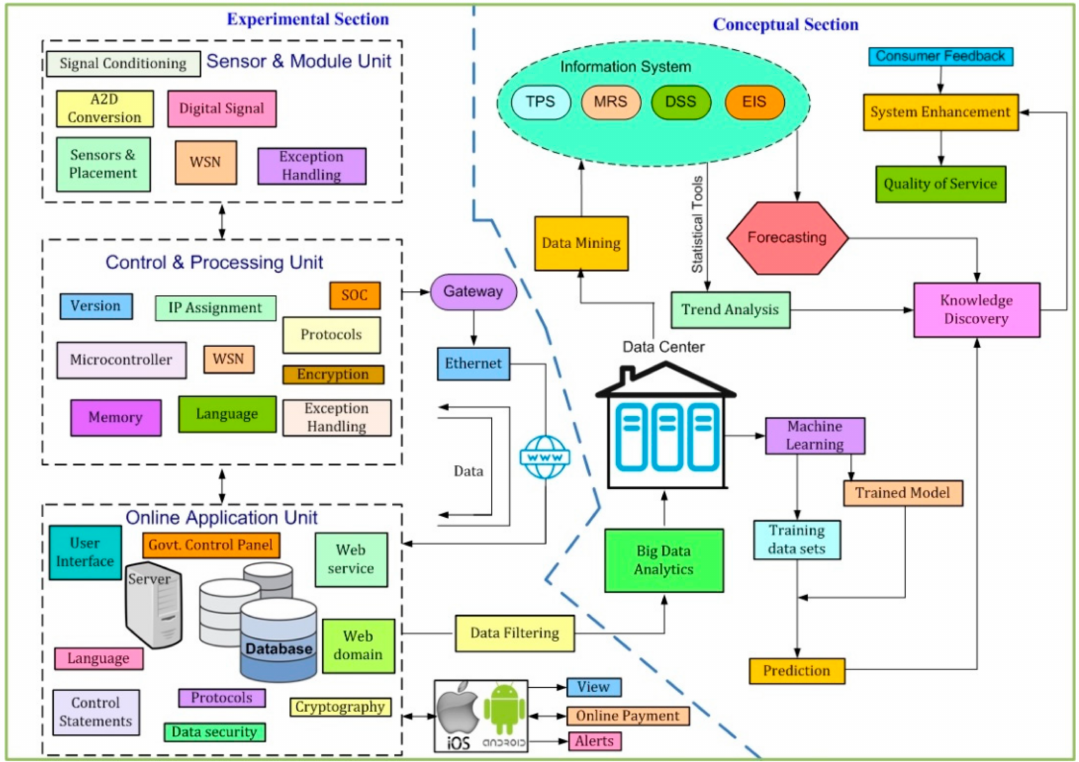
Figure 4. IoT framework concentrated on technological